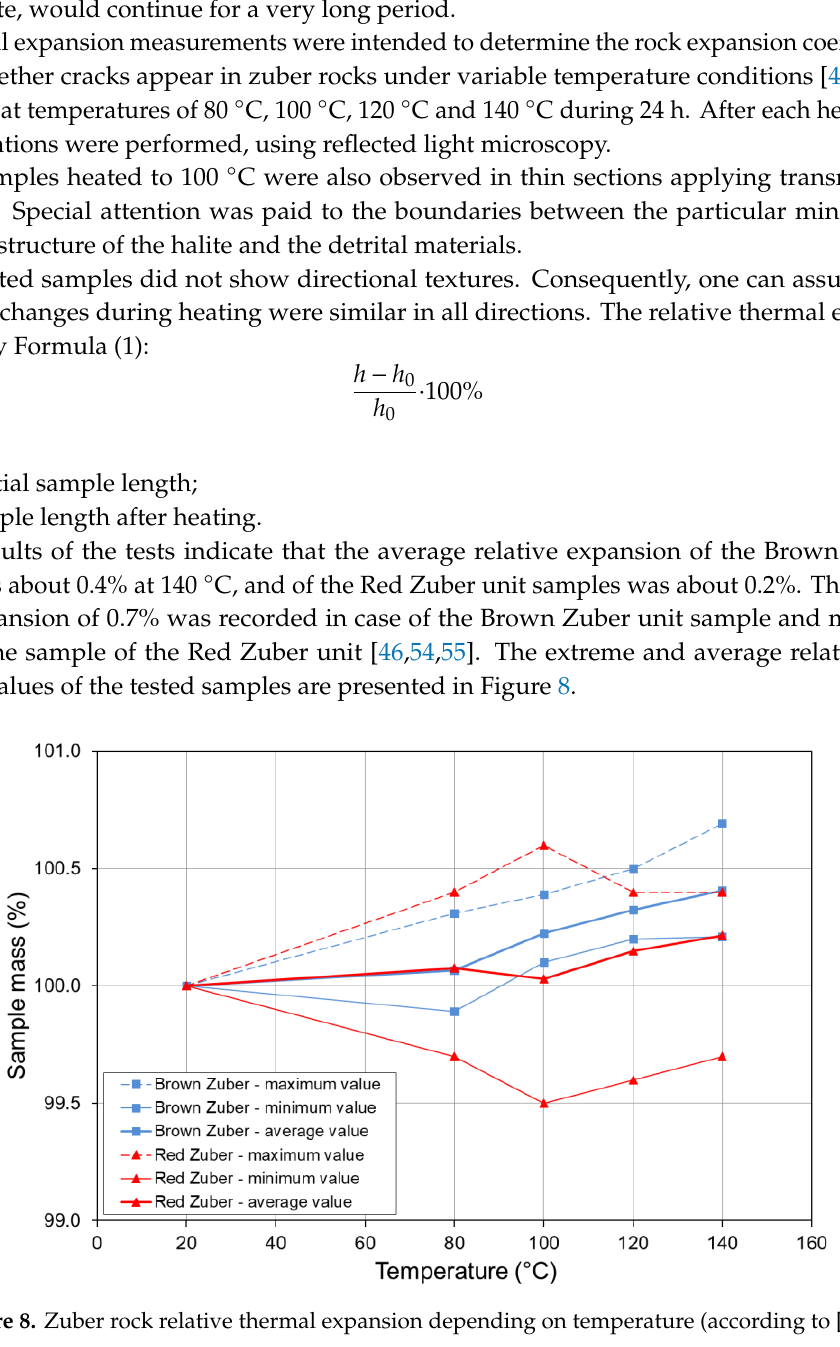
Figure 8. Zuber rock relative thermal expansion depending on temperature (according to [46]).